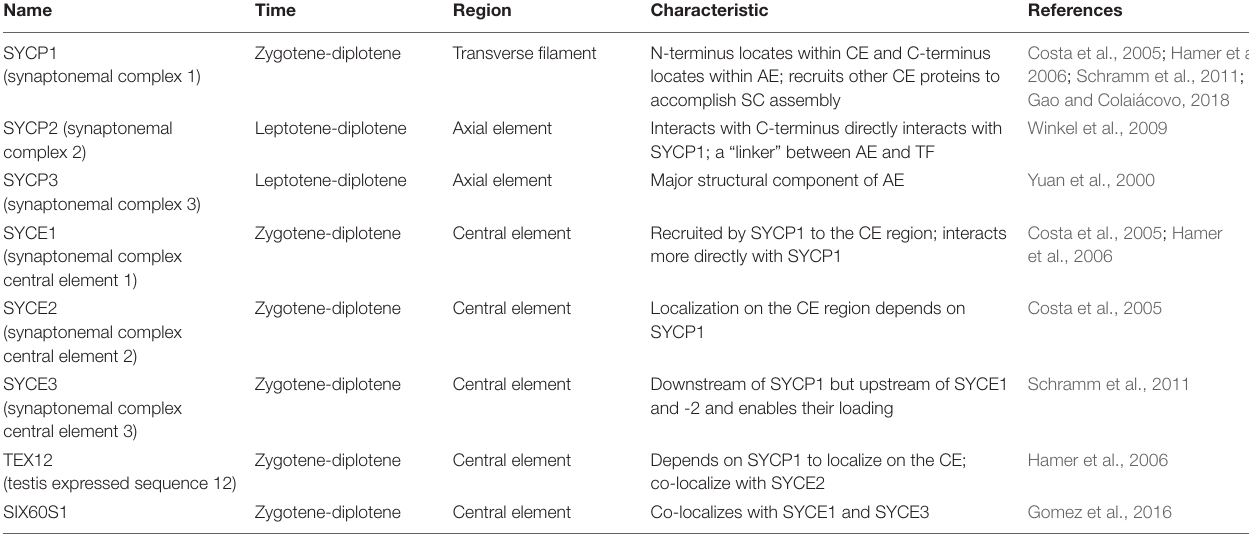
TABLE 2 | Synaptonemal protein complex